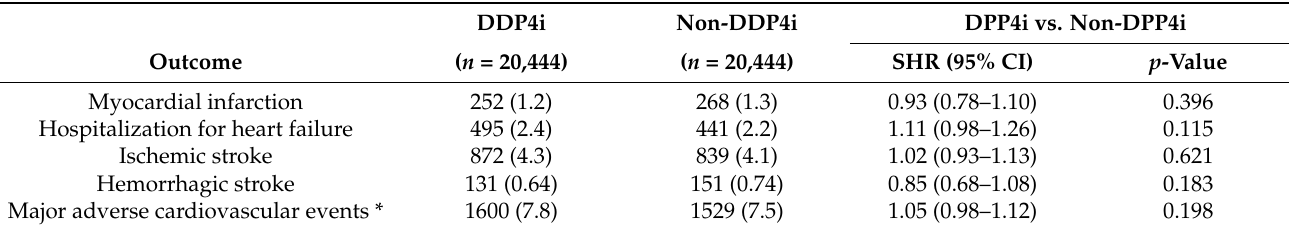
Table 3. Safety outcomes of patients with type 2 diabetes and diabetic retinopathy showing no significant risk in both